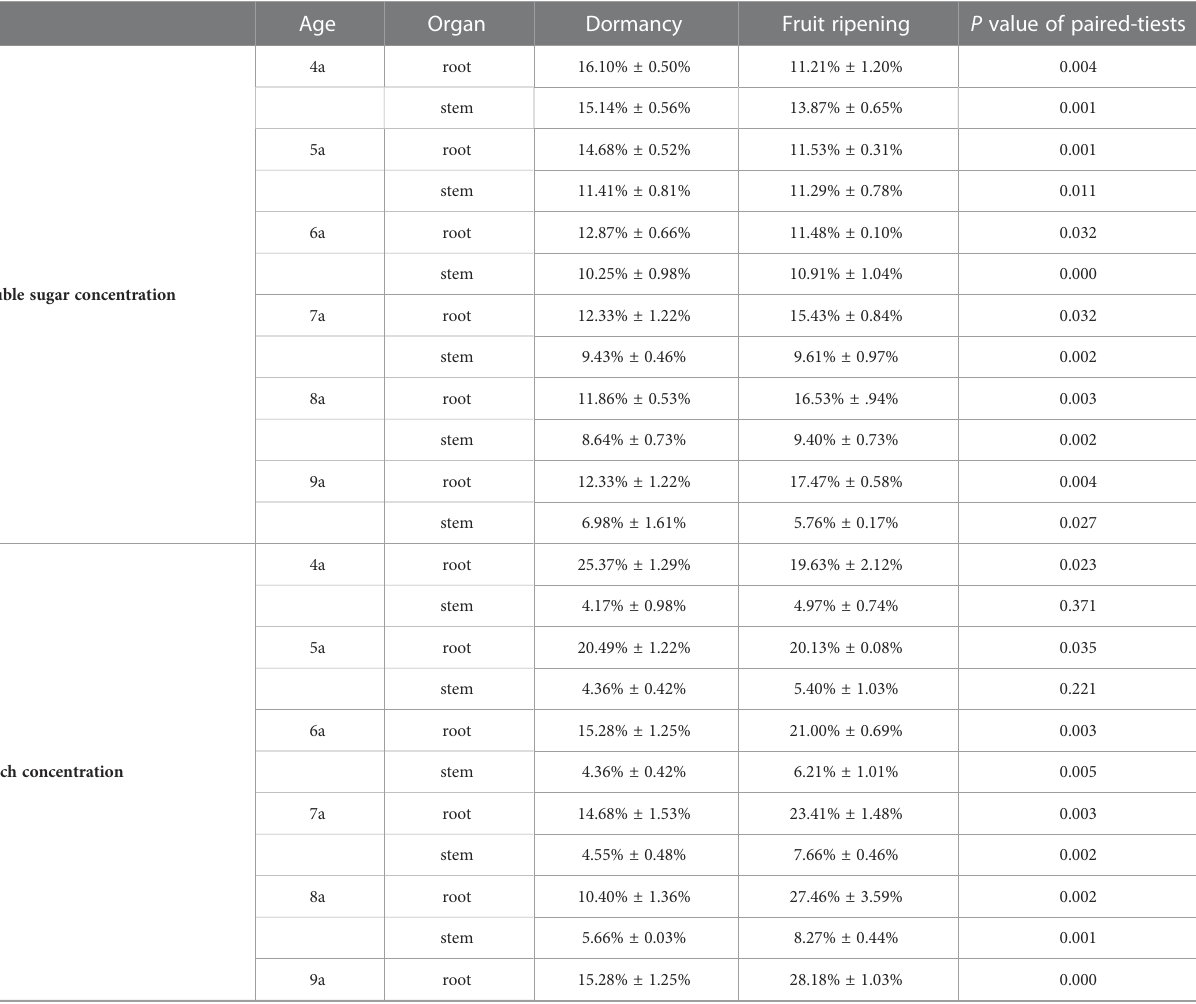
TABLE 5 Concentration and accumulation of soluble sugar, starch, and NSC in each organ of Fengdan during dormancy and fruit ripening. Age Organ Dormancy Fruit